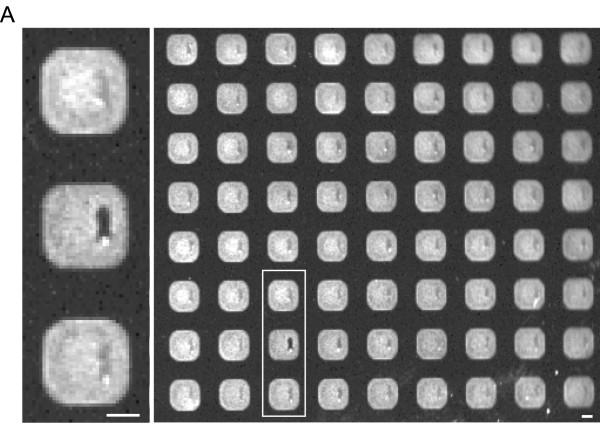
The use of a fluorescence macroscope to assay wound healing after 24 hrs recovery. Fluorescence macroscope image of wells stained for filamentous actin 24 hrs after wounding. A well showing reduced wound healing can be easily distinguished (middle well white box) from wells showing complete healing which are seen as light grey streaks. Bar 1 mm.